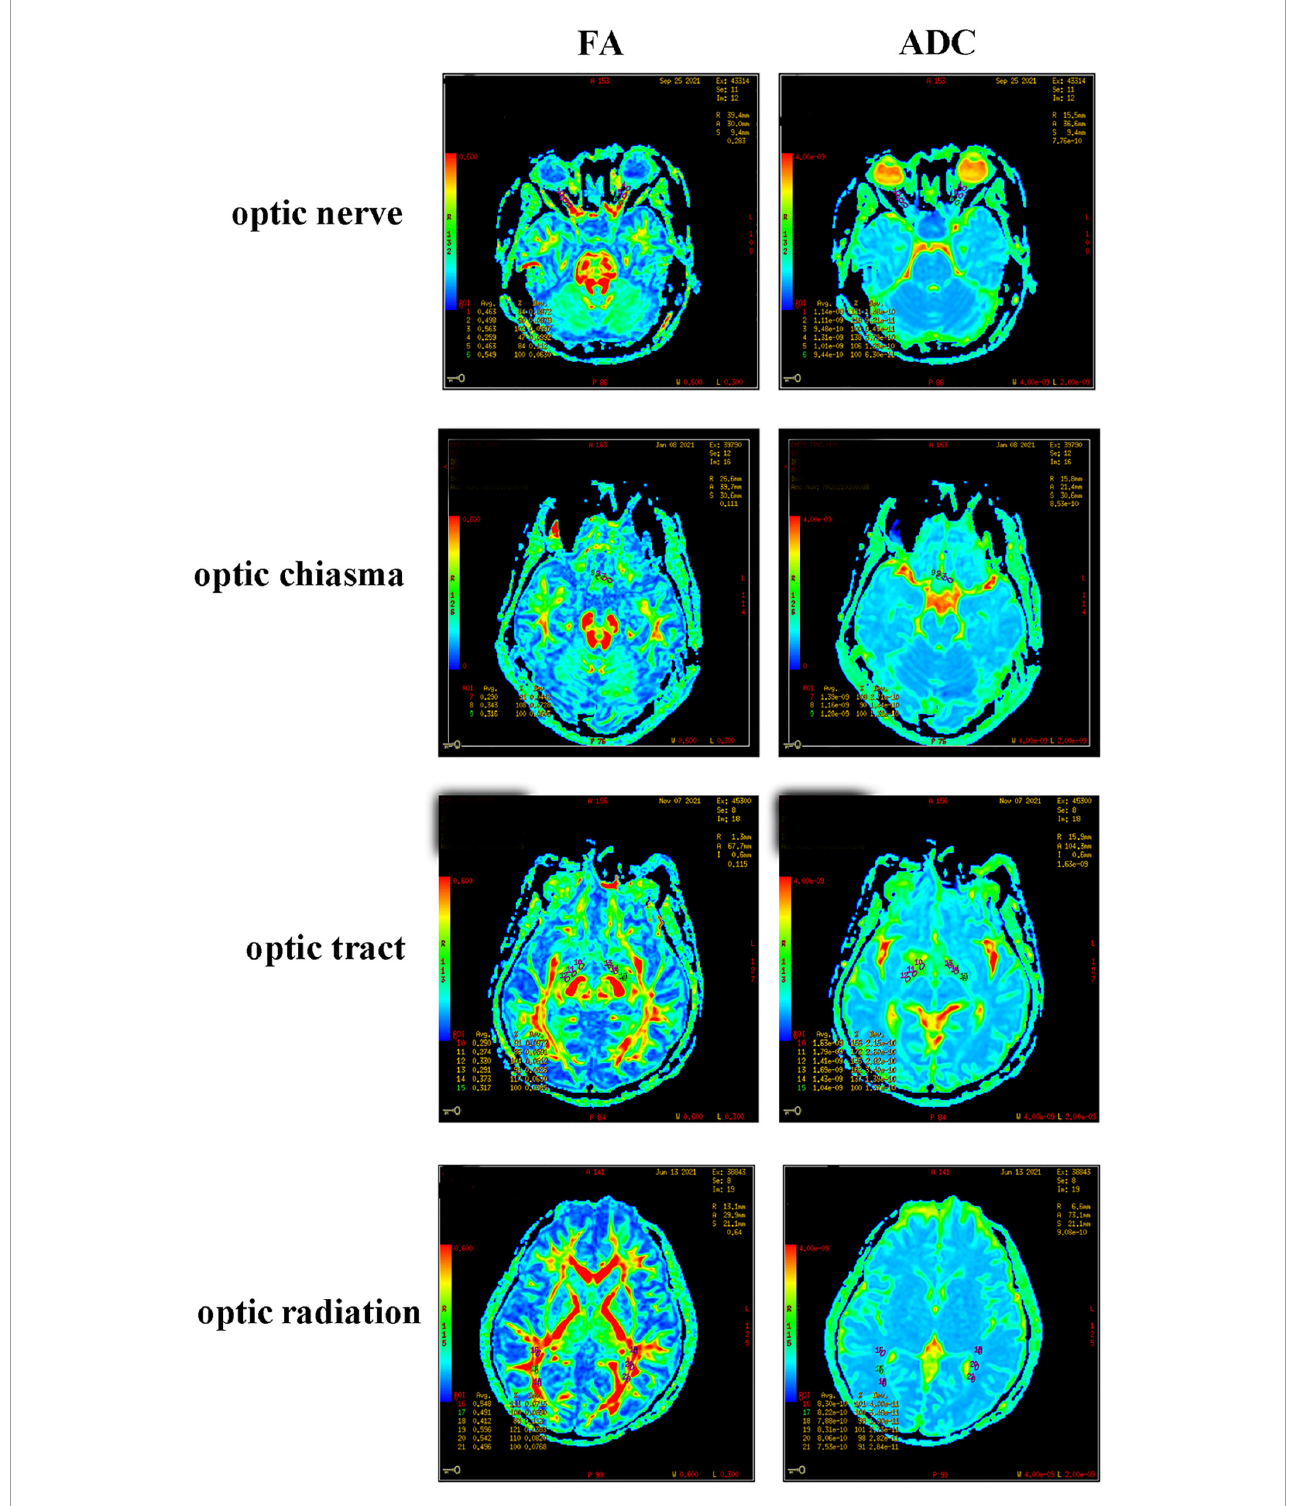
FIGURE2 FA and ADC diagrams of the optic nerve, optic chiasma, optic tract, and optic radiation.